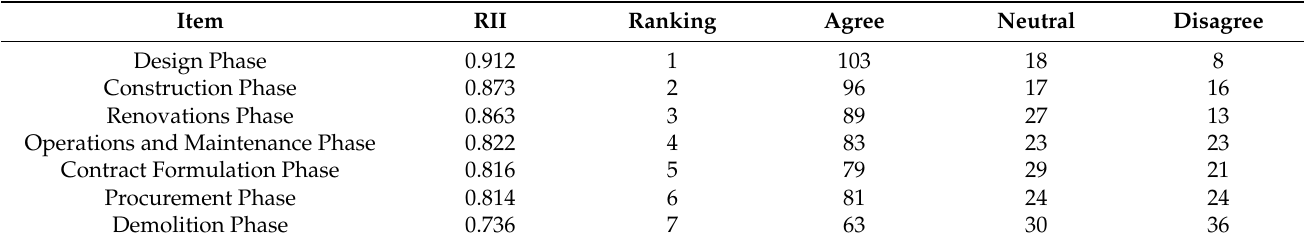
Table 13. RII Ranking of the project phases in terms of their relevance to